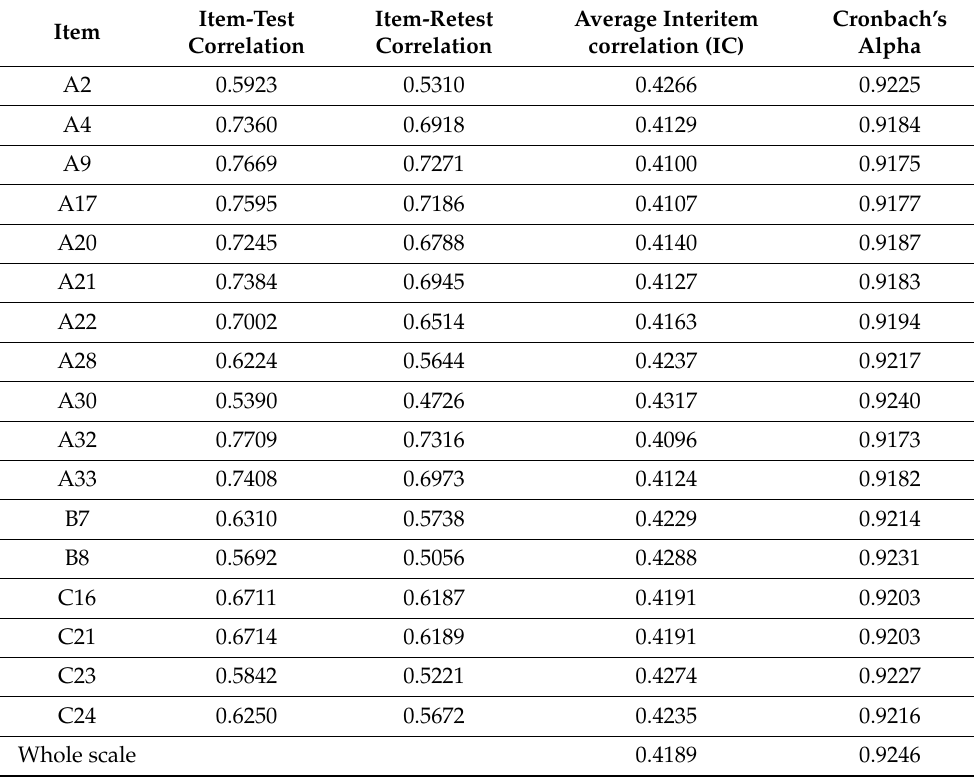
Table 2. Reliability: item-scale correlations and Cronbach’s alpha of the Italian version of the CVSS17.